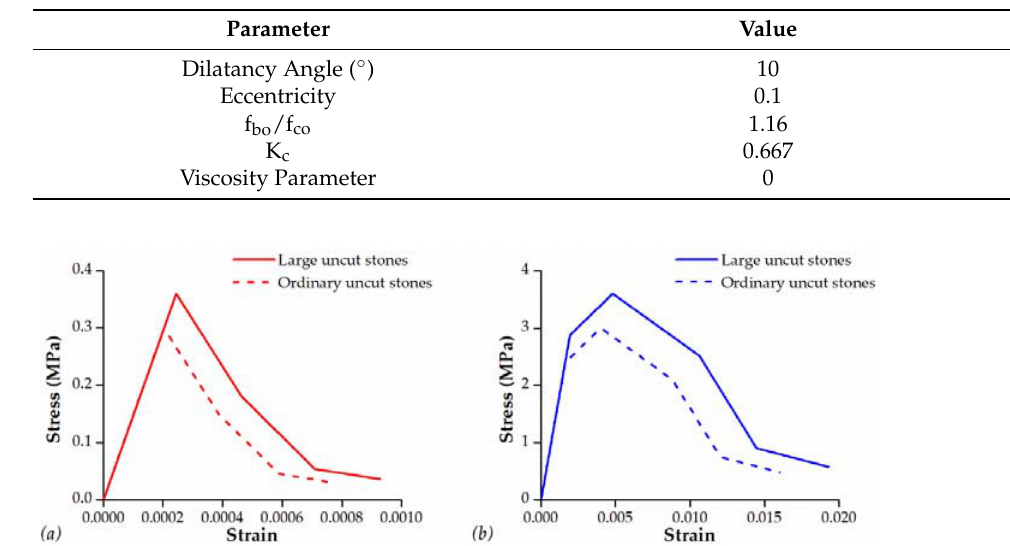
Table 1. Linear and nonlinear parameters of masonry.